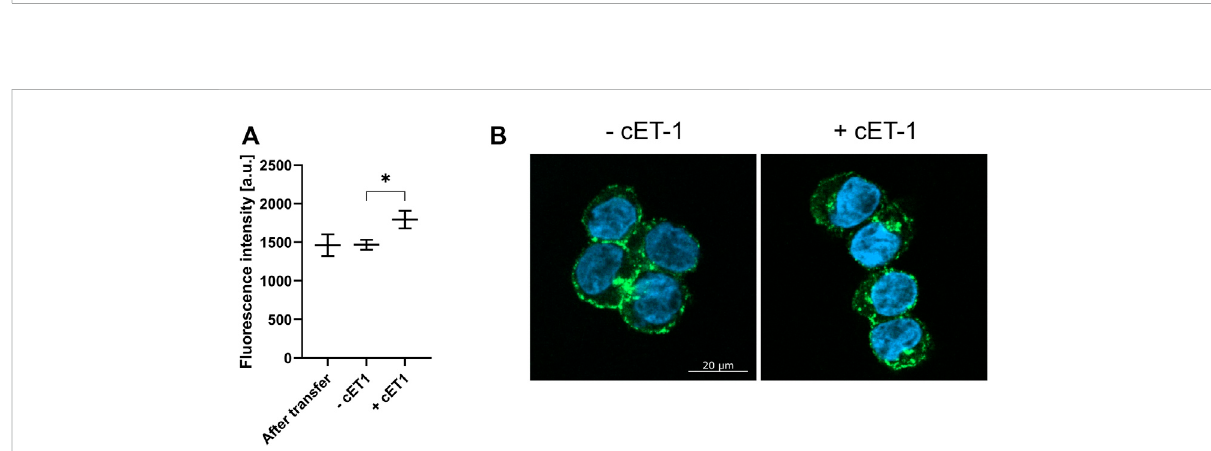
FIGURE 12 Induced internalization of transferred ETB-mNG by cET-1. LAC-puri fi ed ETB-mNG was transferred into HEK293T cells at standard conditions. Cells were washed and subsequently incubated with 500 nM cET-1 for 1 h at 4 ° C. Afterward, they were further incubated at 37 ° C for 1 h, fi xed and ETB-mNG fl uorescence in the cytoplasm was quanti fi ed via ImageJ. (A) Quanti fi cation of ETB-mNG in the cytoplasm of transferred HEK293T cells. Mean±SEM isshown. n =20cells( p < 0.05;paired t -test). (B) Representative images ofHEK293Tcellstreated withorwithout cET-1after ETB- mNG